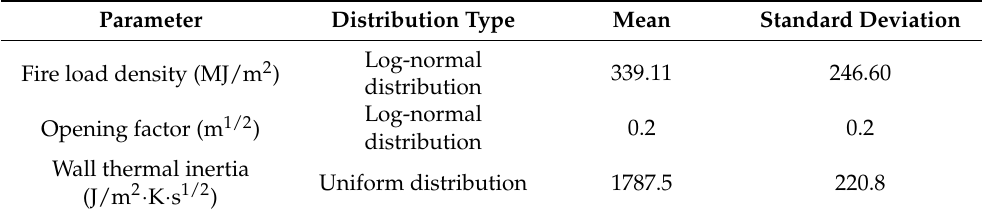
Table 5. Probability distribution of